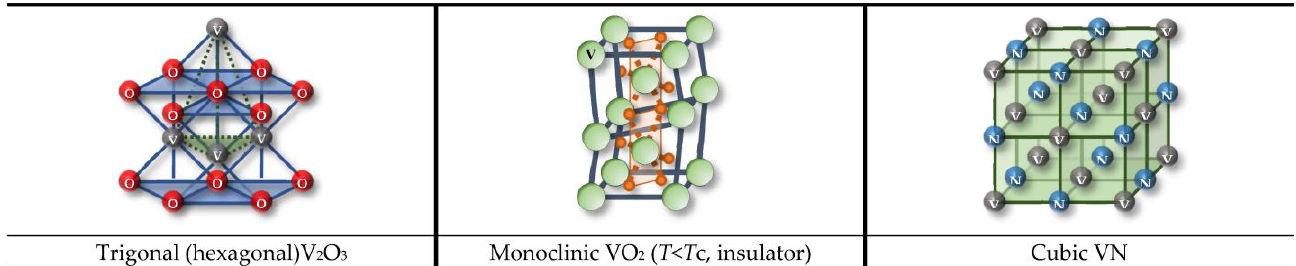
Figure A1. Three primary crystal structures of V 2 O 3 . VO 2 , and VN.